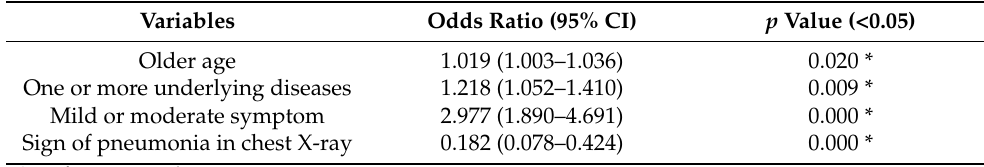
Table 2. Multivariable logistic regression analysis showing the association between different variables and worsening conditions requiring transfer to designated high-level